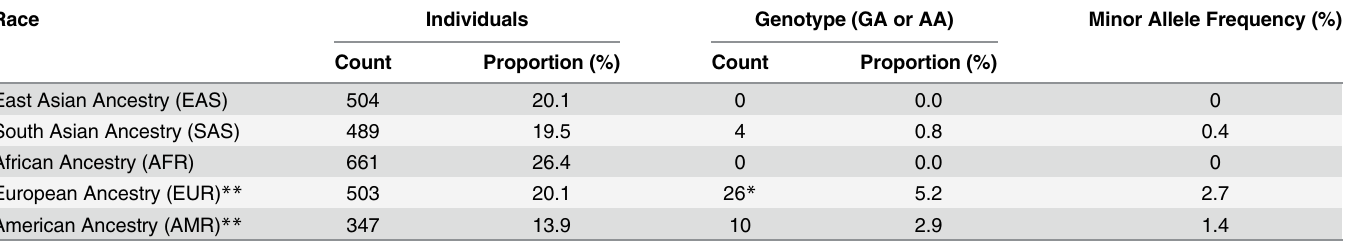
Table 3. Race distribution in 1000 Genome final release Phase 3 (total of 2504 individuals) and genotyping results for SNP rs7080536. ( http://www.